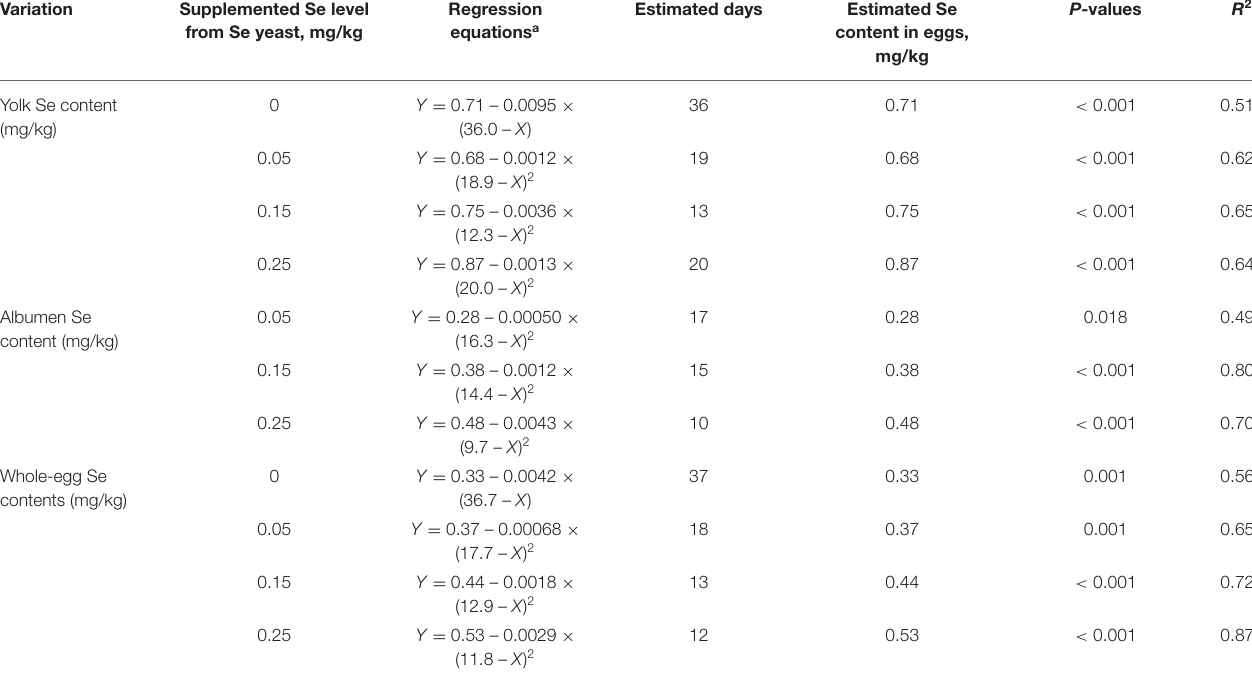
TABLE 6 | Estimated change of Se content in eggs with the increase in experimental days. Variation Supplemented Se level Regression Estimated days Estimated Se from Se yeast, mg/kg equations a content in